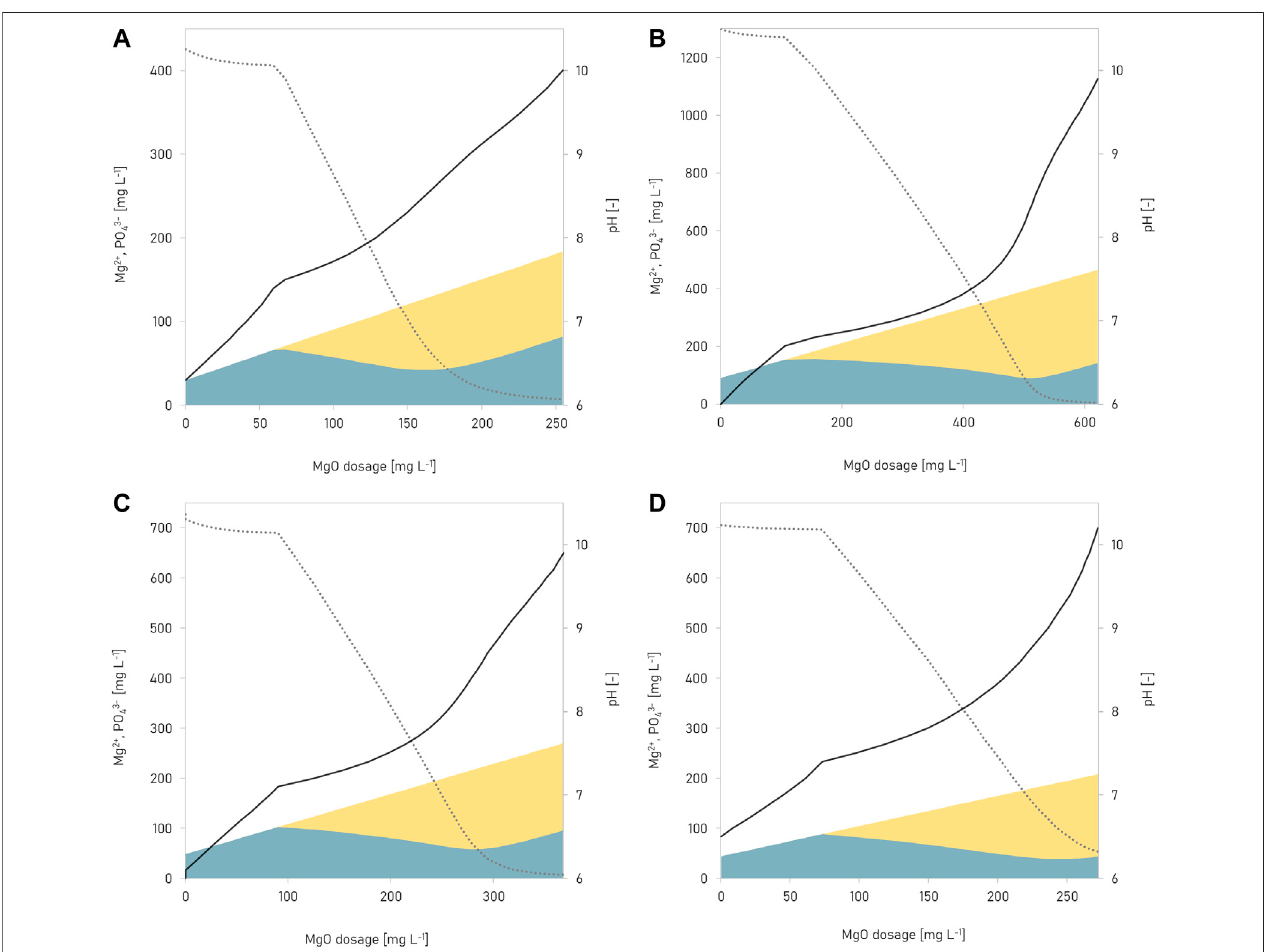
FIGURE2| TheconcentrationofMg 2+ (aq)(blue),Mg 2+ (s)(yellow)andPO 3 − 4 (aq)( ... ),infreshhumanurinetreatedwithMgOat25 ° C.ThesimulatedpH( ― )isshown on the secondary y -axis. Forthe simulations, four different urinecompositions measured in this study were used: FU 1 (A) , FU 2 (B) , FU 3 (C) and FU 4 (D) . See Table 1 for the urine compositions.